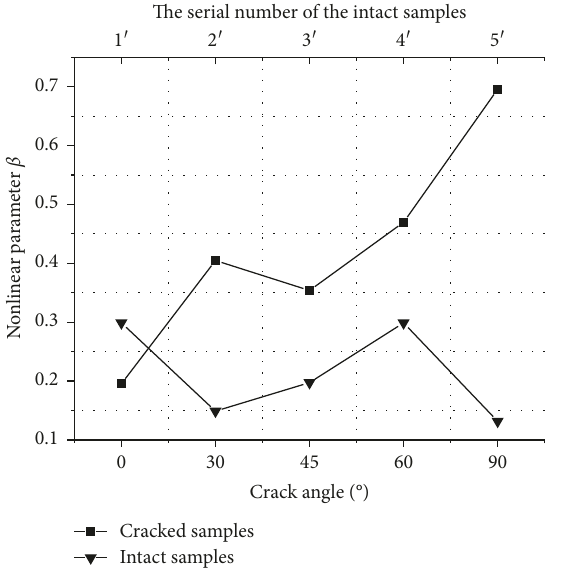
Figure 13: Comparison of the nonlinear parameter β between intact and cracked samples.